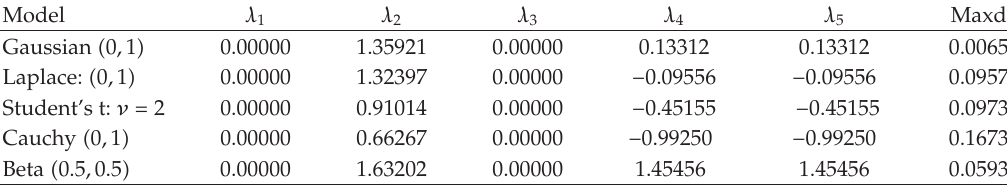
Table 1: Comparison of FPLD approximations for symmetric